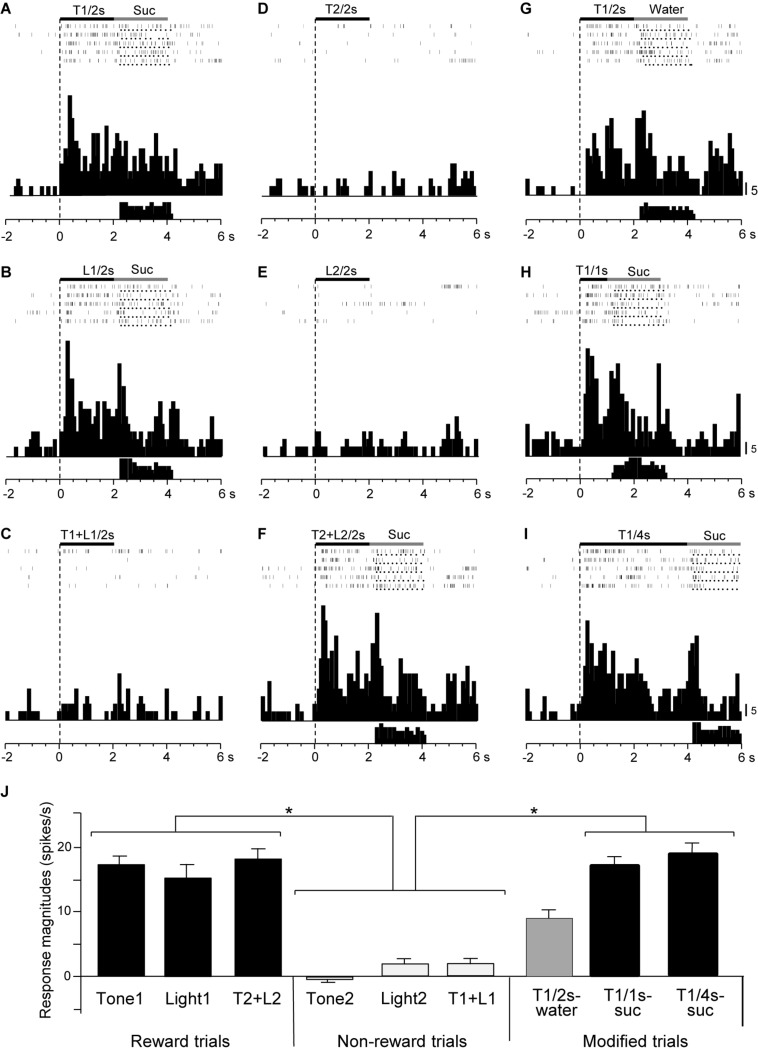
Activity of an early CS+-selective neuron that responds differently to CSs associated with reward and non-reward. (A–F) Responses to CSs in the regular cue-induced licking task. Raster displays and summed histograms indicate neuronal responses to Tone1 associated with the sucrose solution (A), Light1 associated with the sucrose solution (B), Tone1 + Light1 associated with non-reward (C), Tone2 associated with non-reward (D), Light2 associated with non-reward (E), and Tone2 + Light2 associated with the sucrose solution (F). (G–I) Responses to Tone1 associated with reward in the modified cue-induced licking task. Note that the neuron responded to the CSs associated with reward. Black and gray rectangles above the raster displays indicate CS duration and time of reward, respectively. Each dot below the raster line indicates one lick; each upper histogram shows summed neuronal responses; and each lower histogram shows summed licks. Abscissas indicate time; onset of CS at time 0; negative values represent the pre-trial control. Histogram bin width, 100 ms. Suc, 0.3 M sucrose solution. (J) Comparison of neuronal responses to the CSs (mean firing rate ± SEM). T1/2s, 2-s Tone1; L1/2s, 2-s Light1; T1 + L1/2s, 2-s Tone1 + Light1; T2/2s, 2-s Tone2; L2/2s, 2-s Light2; T2 + L2/2s, 2-s Tone2 + Light2; T1/1s, 1-s Tone1; T1/4s, 4-s Tone1; T1 + L1, Tone1 + Light1; T2 + L2, Tone2 + Light2; T1/2s-water, 2-s Tone1 associated with water; T1/1s-suc, 1-s Tone1 associated with sucrose; T1/4s-suc, 4-s Tone1 associated with sucrose. *p < 0.05 (Bonferroni test).